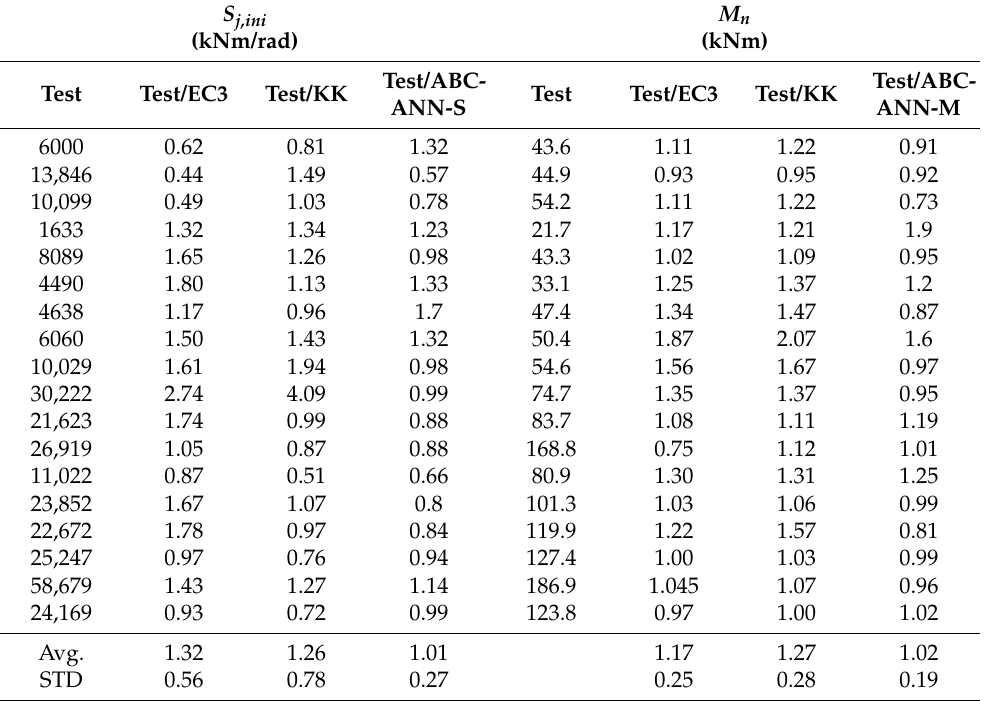
Table 6. Comparison of different models with literature test data, as obtained in terms of S j,ini and M n . S j,ini